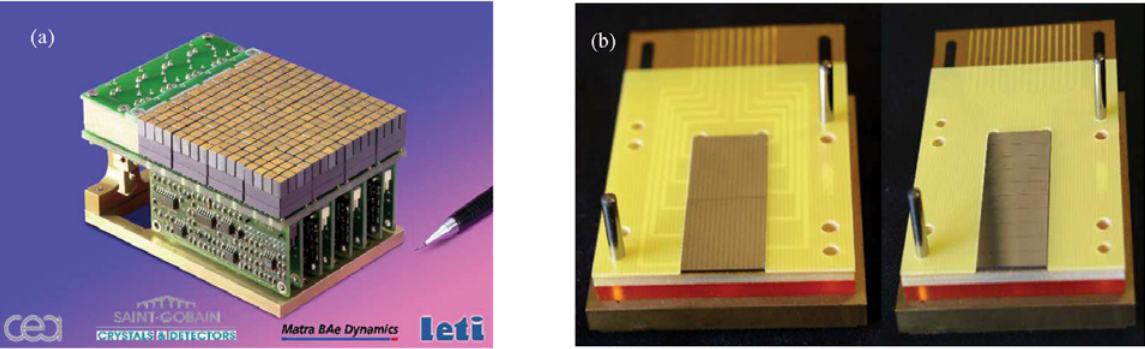
Figure 25. (a) CdZnTe detector prototype for gamma cameras [93]; it consists of 256 single CdZnTe detectors (4 x 4 x 6 mm 3 ) assembled to realize a small imager. (b)